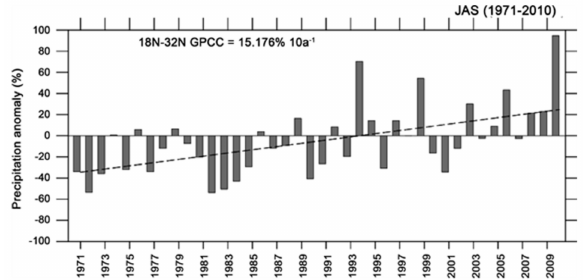
Figure 14. Temporal variation of the interannual summer precipitation anomaly (%) between 1971 and 2010